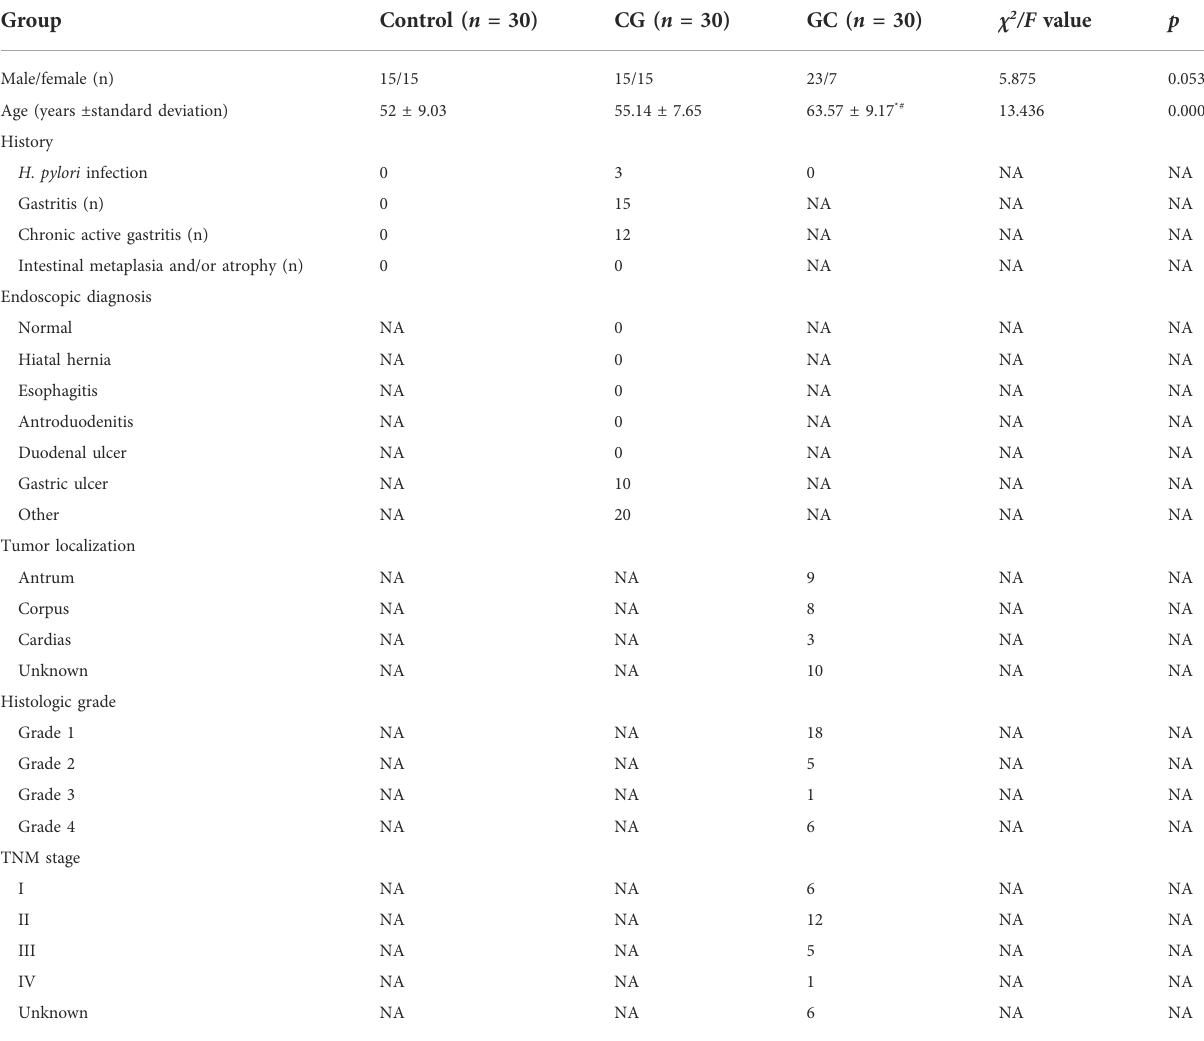
TABLE 1 Clinical characteristics of the